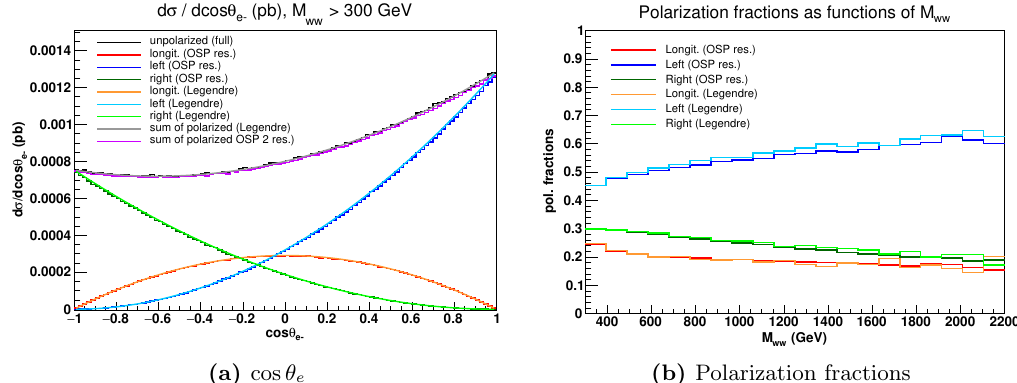
Figure 2. Distribution of electron cos (cid:18) in the W (cid:0) reference frame (left), polarization fractions as functions of M WW (right). The polarization components obtained by expanding the full angu- lar distribution on Legendre polynomials are shown in lighter colors. The darker histograms are obtained integrating the polarized amplitudes squared. The positively charged W is